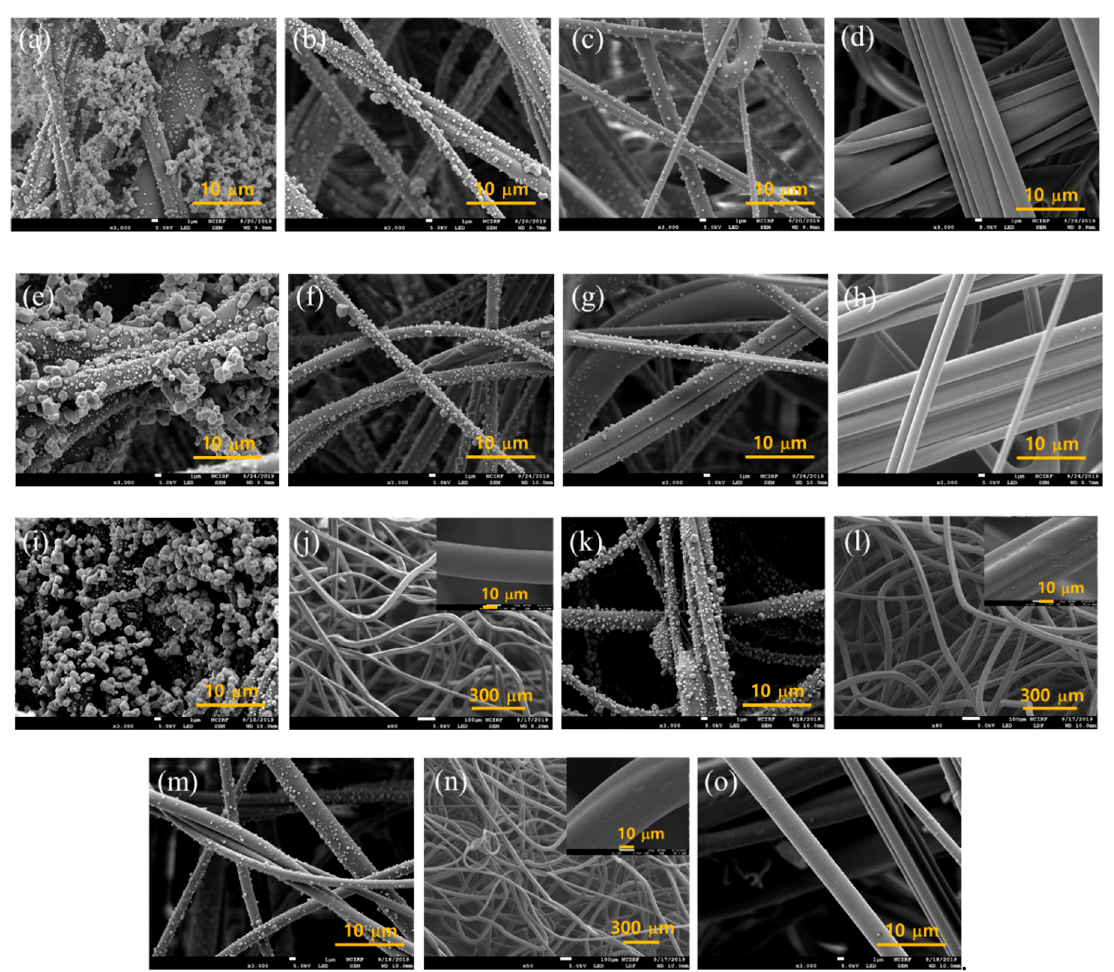
Figure 9. SEM images of 4-Layer construction after 30 mg loading (15 cm/s). ( a – d ), 4-layers without gap; ( a ) 1st MB layer with 0 gap, ( b ) 2nd MB layer with 0 gap, ( c ) 3rd MB layer with 0 gap, ( d ) 4th MB layer with 0 gap. ( e )~( h ), 4-layers with 5 mm air gap; ( e ) 1st MB layer with air gap, ( f ) 2nd MB layer with air gap, ( g ) 3rd MB layer with air gap, ( h ) 4th MB layer with air gap. ( i – o ), 4-MB layers with spacer webs; ( i ) 1st MB layer with S gap, ( j ) 1st S layer, ( k ) 2nd MB layer with S gap, ( l ) 2nd S layer, ( m ) 3rd MB layer with S gap, ( n ) 3rd S layer, ( o ) 4th MB layer with S gap. Table 4. Loaded mass for each layer for 4-layer constructions.